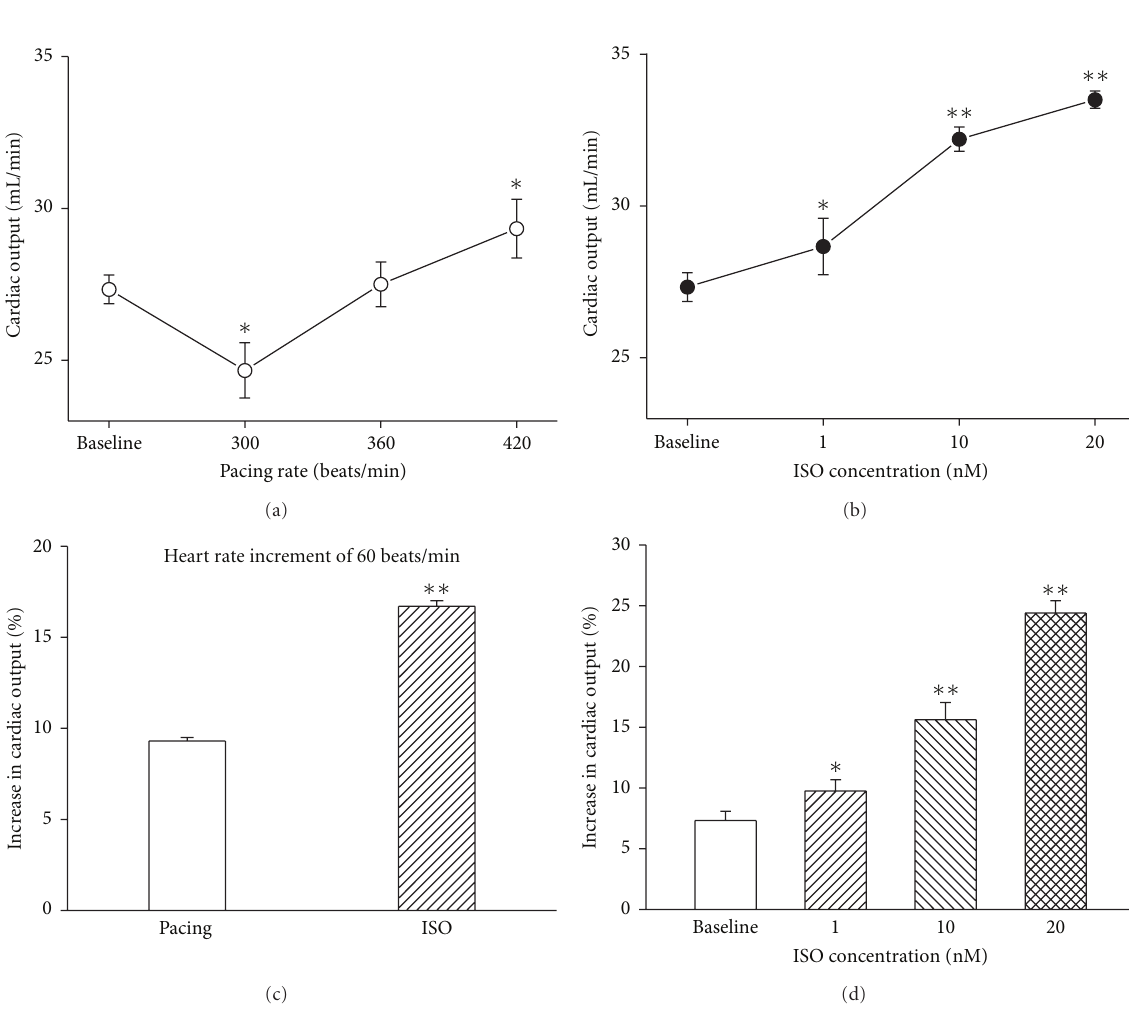
Figure 1: Cardiac output of isolated working hearts in the pacing and ISO treatment. All data are mean ± SEM. (a) Cardiac output of isolated working hearts in di ff erent rates of pacing. The n = 6 hearts. ∗ P < 0 . 05 versus baseline. (b) Cardiac output in di ff erent concentrations of ISO treatment. The n = 6 hearts in each ISO concentration. ∗ P < 0 . 05 or ∗∗ P < 0 . 01 versus baseline. (c) The percentage increases in cardiac output in the heart rate increment of 60 beats/min. The n = 6 hearts for each group. ∗ P < 0 . 05 versus the pacing group. (d) The percentage increases in cardiac output at the pacing of 420 beats/min without and with ISO treatment. The n = 6 hearts in each ISO concentration. ∗ P < 0 . 05 or ∗∗ P < 0 . 01 versus